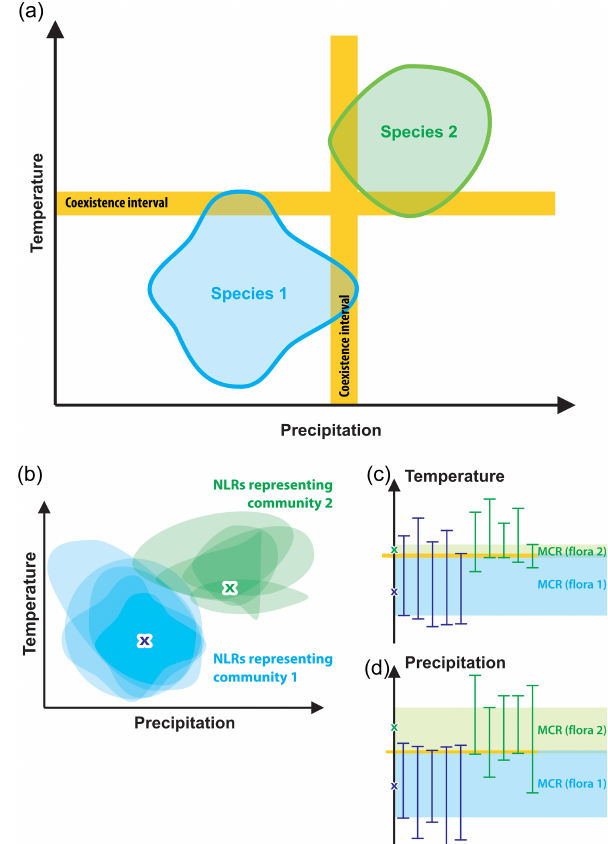
Figure 4. Pseudo-coexistence as a result of the representation of the climate niche using minimum and maximum tolerances. Panel (a) : bivariate climate niches of two mutually exclusive species. These species have no overlapping climate space but still reconstruct nar- row coexistence intervals (orange bars) along univariate axes. Panel (b) : bivariate climate niches of NLRs of two floras growing under substantially different climates (indicated by x). Note that only the niches of three of the Community 1 species overlap with one or two of the Community 2 species. Panels (c, d) : univariate mutual cli- mate ranges (MCR) of both communities; the overlap of the two MCR result in highly precise coexistence intervals for the artifi- cially mixed communities including all elements from Community 1 and Community